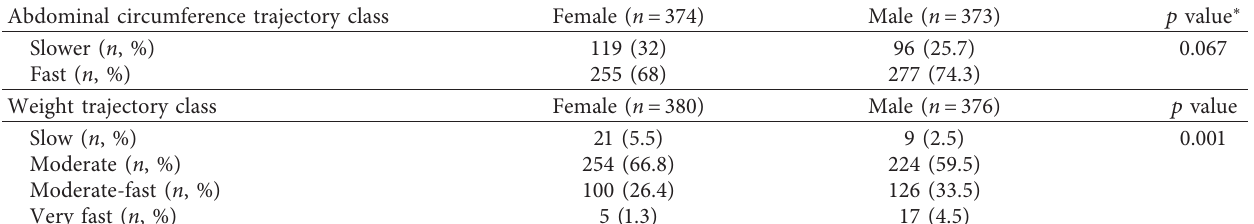
Table 2: Abdominal circumference and estimated weight trajectory class and child sex figures in number with (%).